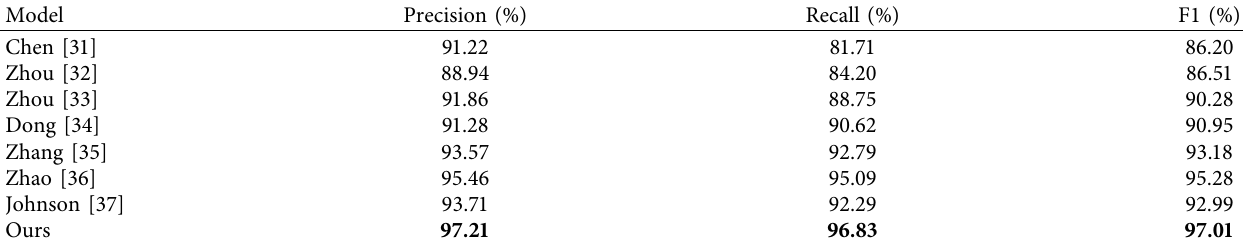
Table 4: Experimental results of MSRA dataset.